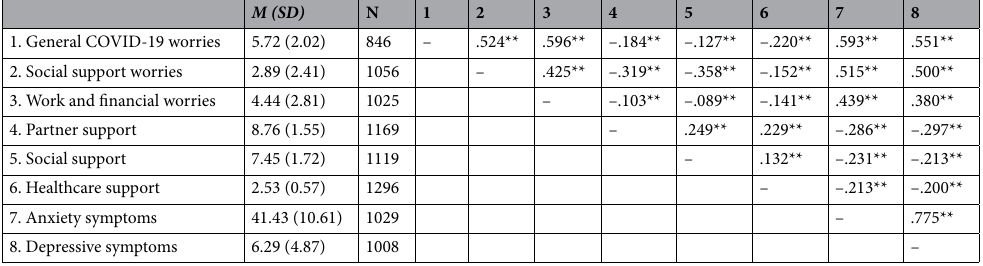
Table 2. Summary statistics and correlations among the variables in the study. Notes. M = mean, SD = standard deviation, N = sample, values; * p < .05, ** p < .01.